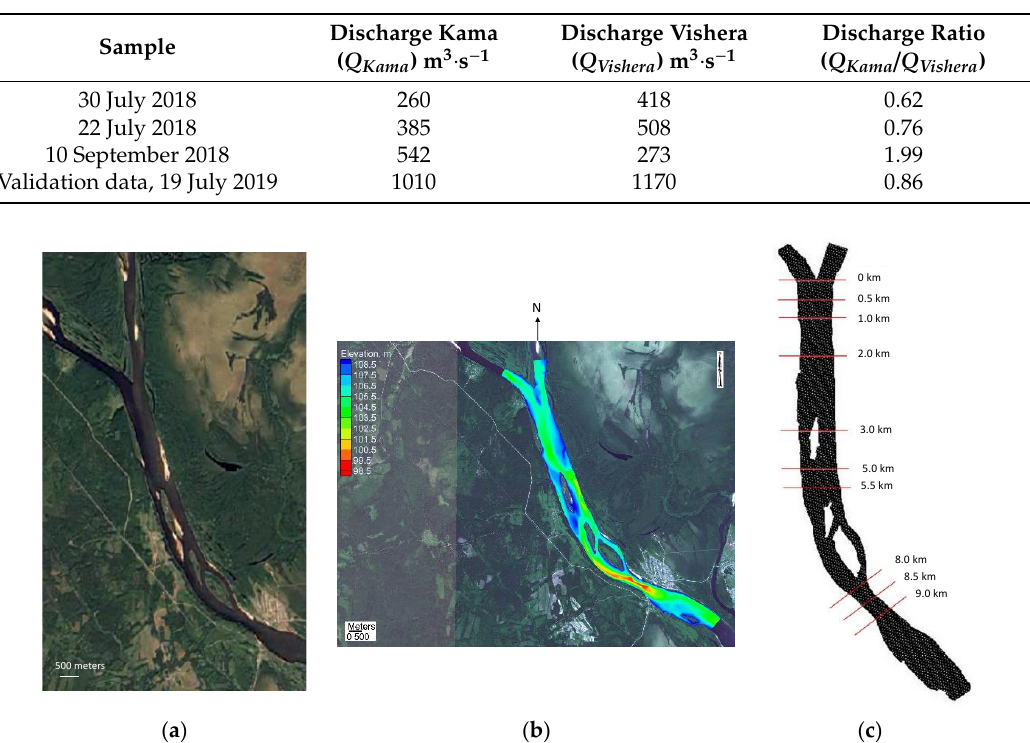
Figure 2. The junction of the Vishera and Kama rivers in the region of Perm, western Urals, Russia, © GoogleEarth ( a ) showing the altitude of the river bed measured using a SyQwest HydroBox sonar to get flow depths and dGPS position to convert these into altitudes ( b ) and the locations of cross-sections used in the analysis ( c ).